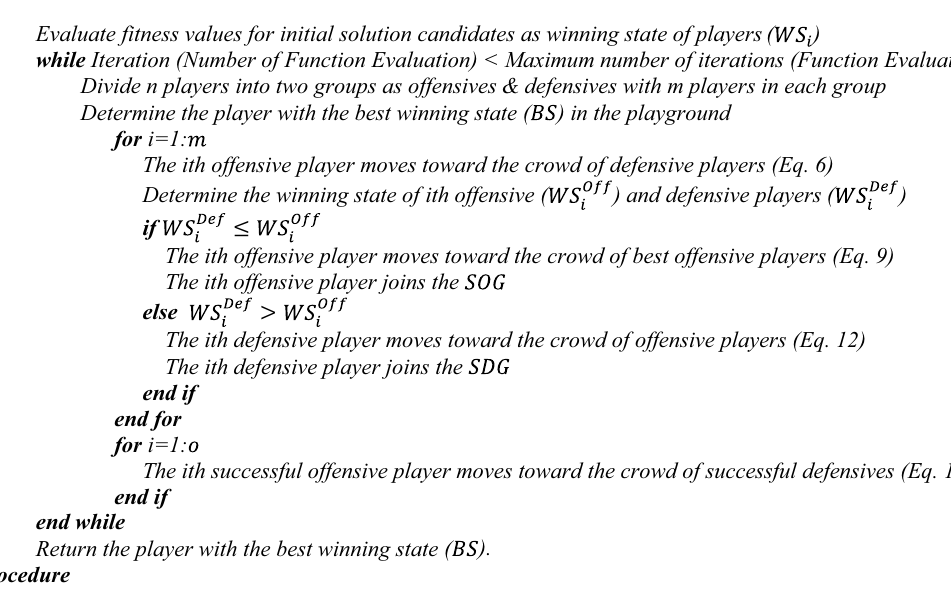
Figure 3. Pseudo code of the